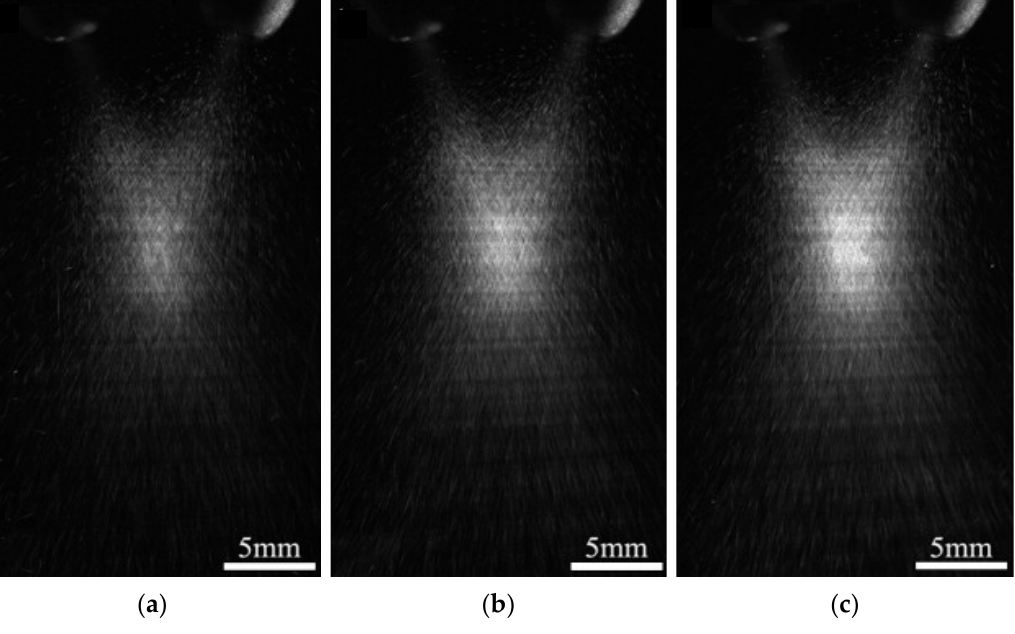
Figure 12. Powder distribution at different powder flow rates: ( a ) 0.052 g/s, ( b ) 0.075 g/s and ( c ) 0.088 g/s (reproduced with permission from [70]; Copyright © 2012 Elsevier).